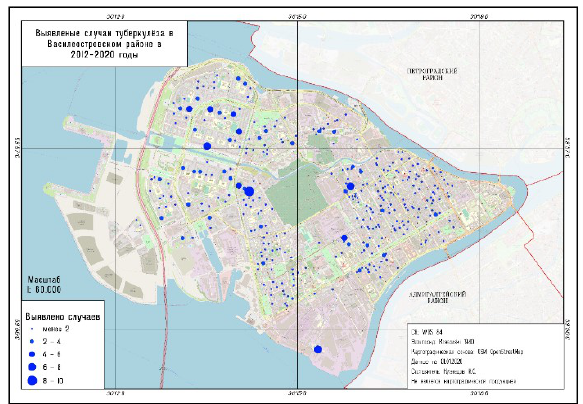
Figure 6 . Map of detected tuberculosis infection cases,